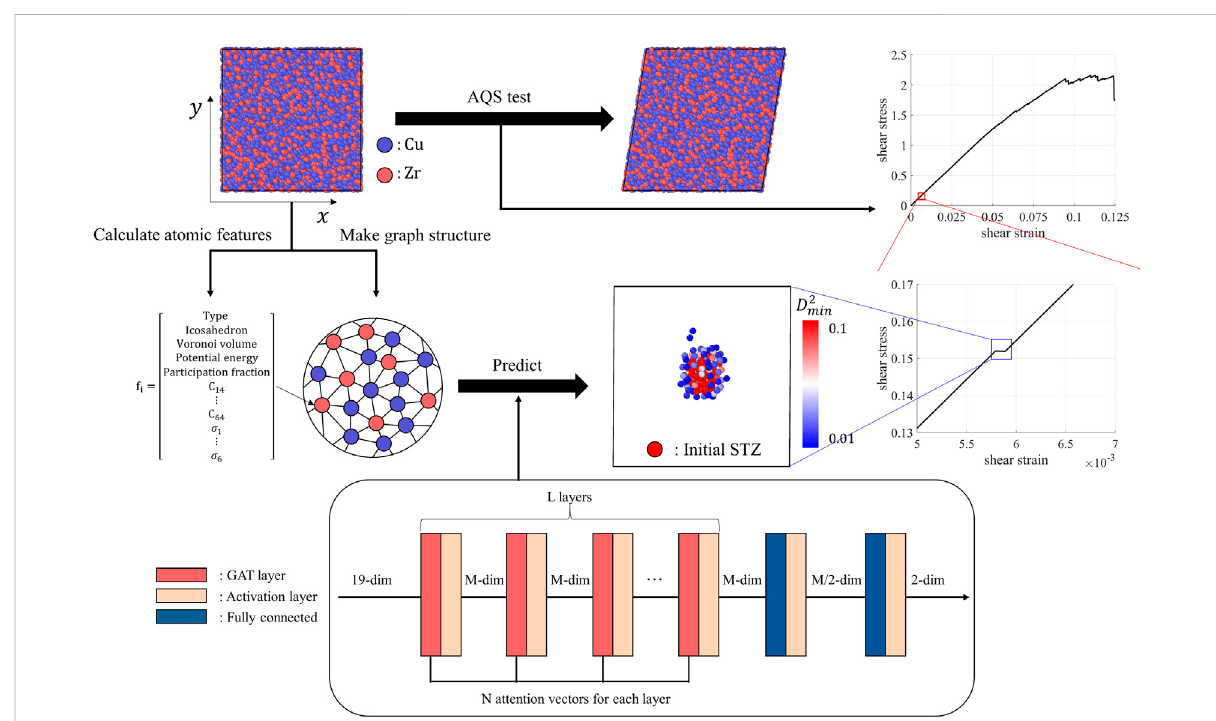
FIGURE 1 Schematicdiagramoftheoverallprocedureforpredictingsheartransformedatoms.WeconductedanAQS(athermalquasi-staticshear)testof six different directions with 75 different Cu 64 Zr 36 bulk metallic glass specimens. Then, we de fi ned the initially STZ activated atoms as label 1 and the others as label 0.To predict theinitiallyshear transformedatoms,we calculate variousatomic properties and assigned those values as nodefeatures of a metallic glass graph structure. The graph structure with the node features is given as the input of a model with a GAT (graph attention network) and fully connected